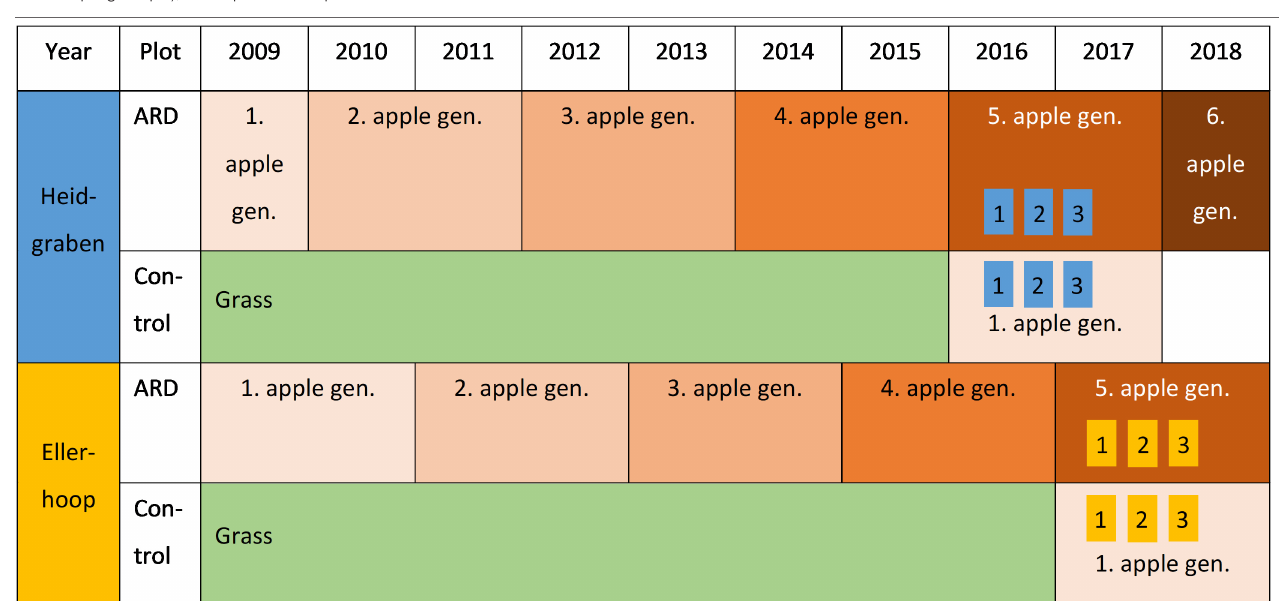
TABLE 1 | Experimental setting and sampling time points at the two sites “Heidgraben” and “Ellerhoop” (1 = sampling in July, 2 = sampling in November, and 3 = sampling in April); n = 4 plots with 3 plants each.